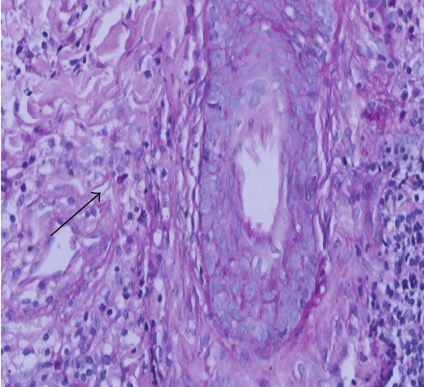
Figure2:Onesporewasnotedinthedermiswhichwasstainedwith D-periodic acid-Schiff (D-PAS).